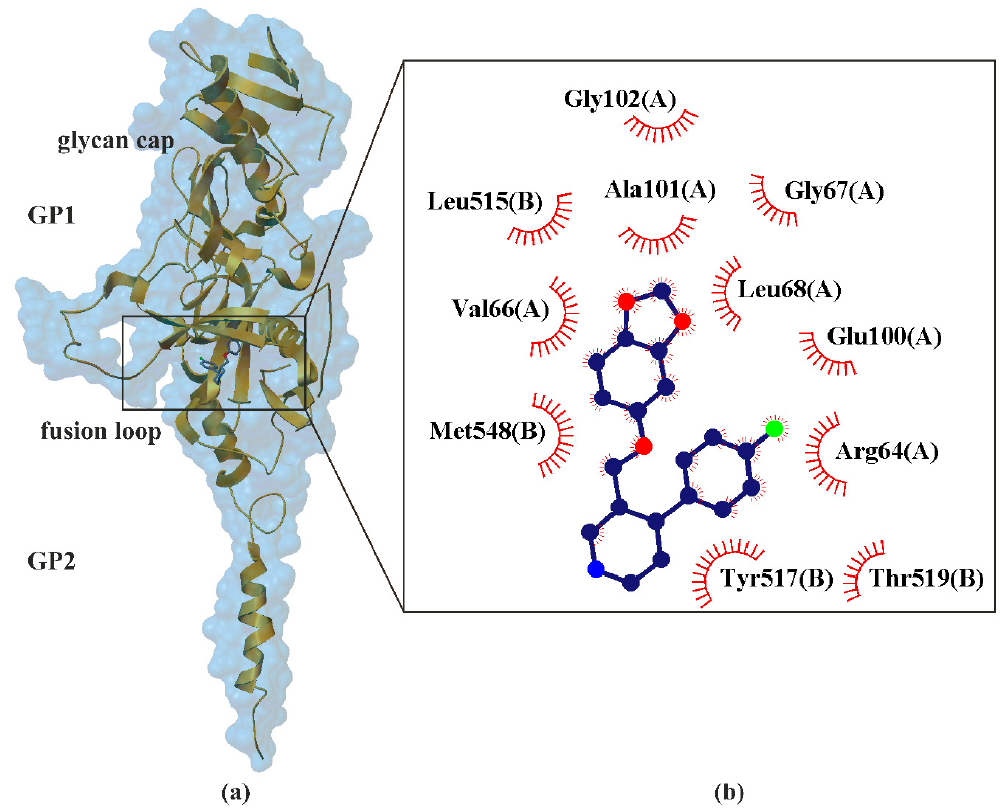
Figure 5. X-ray structure of paroxetine bind in the hinge region of the Ebolavirus (EBOV) glycoprotein (GP) ( a ), with the enlarged area showing the structural elements around the ligand-biding site (PDB ID: 6F6I, 2.40 Å) [59]. Residues that form hydrogen bonds (dashed lines) with paroxetine are shown in ball-and-stick representation with the interatomic distances shown in Å. Residues forming Van der Waals interactions with paroxetine are shown as labeled arcs with radial spokes that point toward the ligand atoms ( b ).